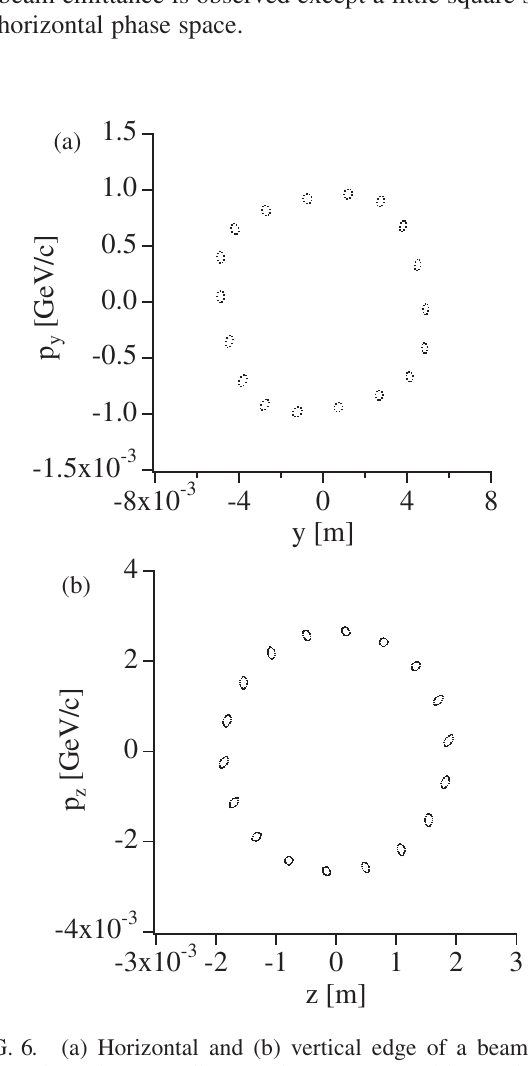
the BTL is shown in Fig. 6. In this case, 18 phase space positions with the same amplitude in horizontal direction have 18 particles in vertical direction. Not much distortion of beam emittance is observed except a little square shape in horizontal phase space.